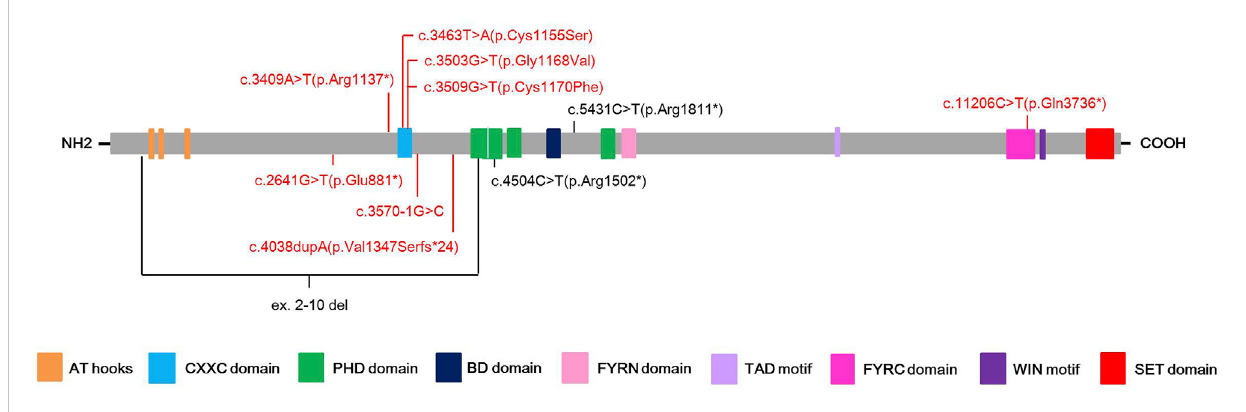
FIGURE 1 Schematic presentation of the KMT2A protein with domain structure and the localization of the eleven different variants found in this study. Red color highlights the novel variants, while black color stands for known pathogenic